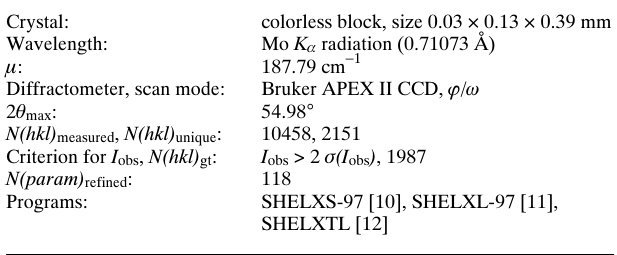
Table 1. Data collection and handling.